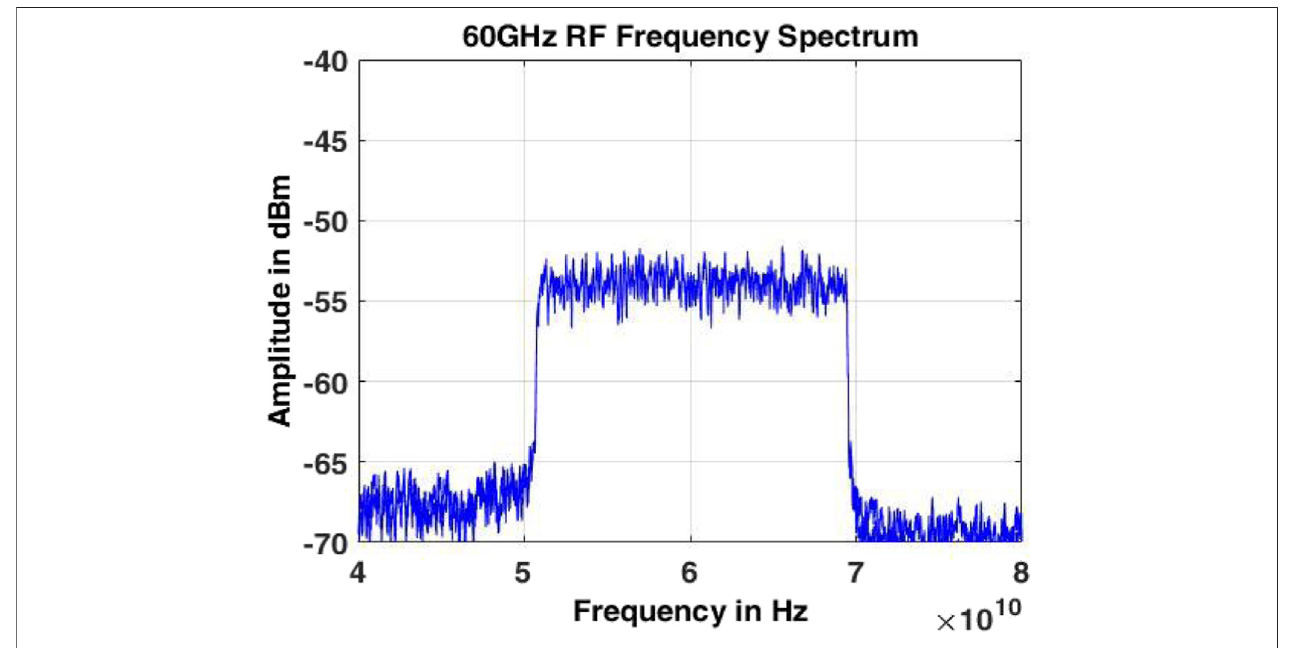
FIGURE 6 | 60 GHz RF spectrum.